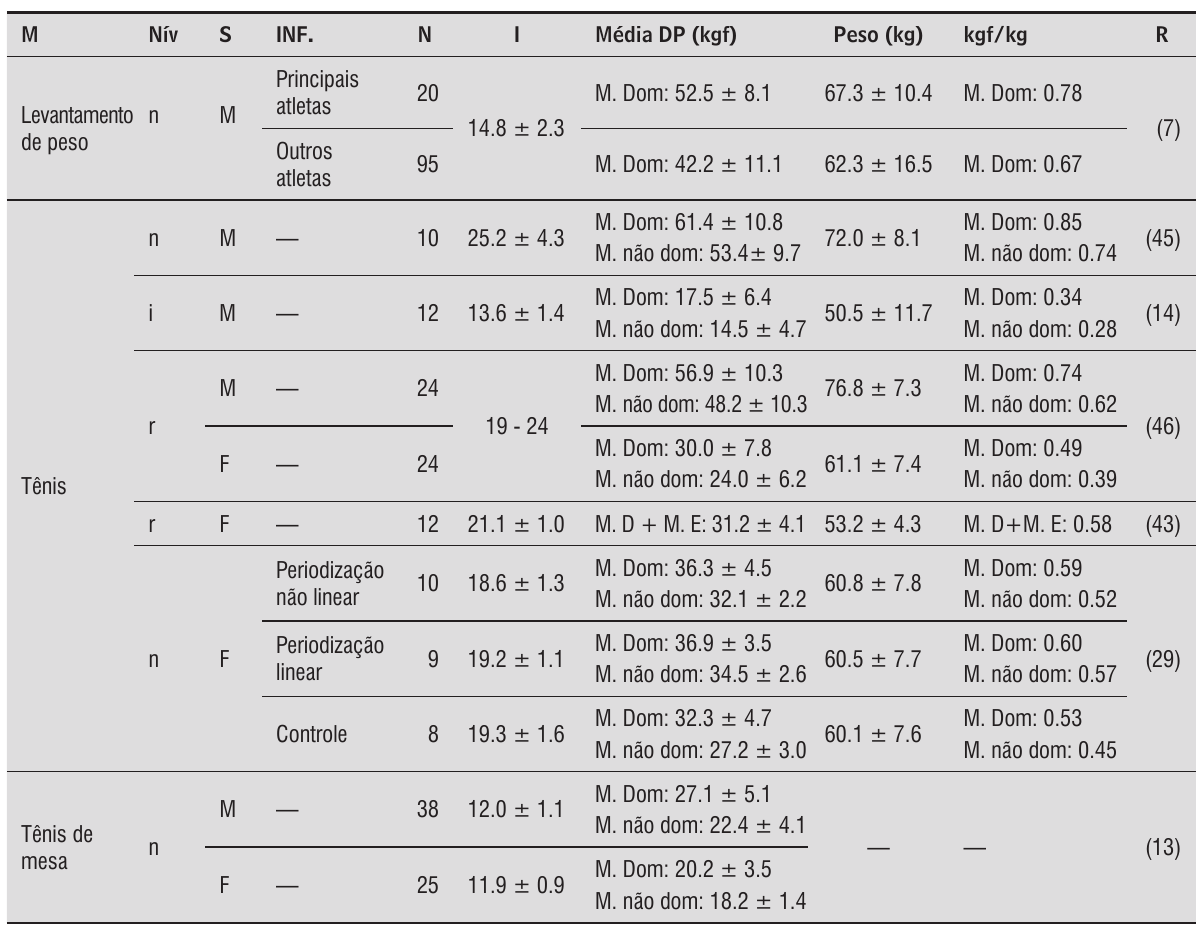
Tabela 3 - Valores da força de preensão manual em diferentes tipos de modalidades individuais olímpicas